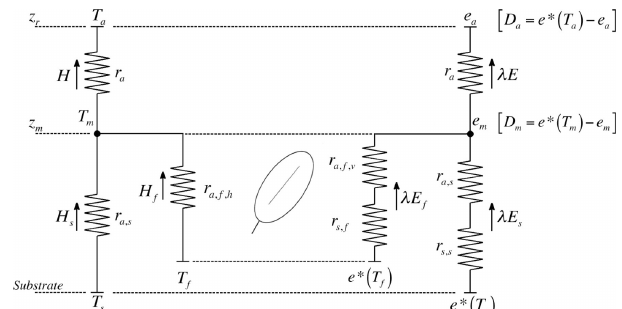
Figure 1. Resistance networks and potentials for a two-layer rep- resentation of the convective fluxes (sensible heat and latent heat) within the canopy. The nomenclature used is given in the list of